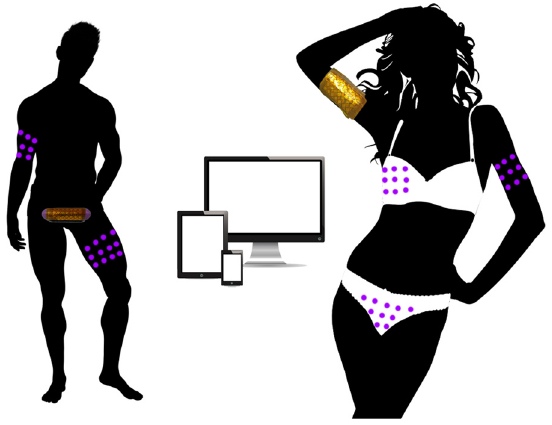
Figure 23: By using the TouchYou device, the couple can use their own body for receiving and transmitting remote sexual